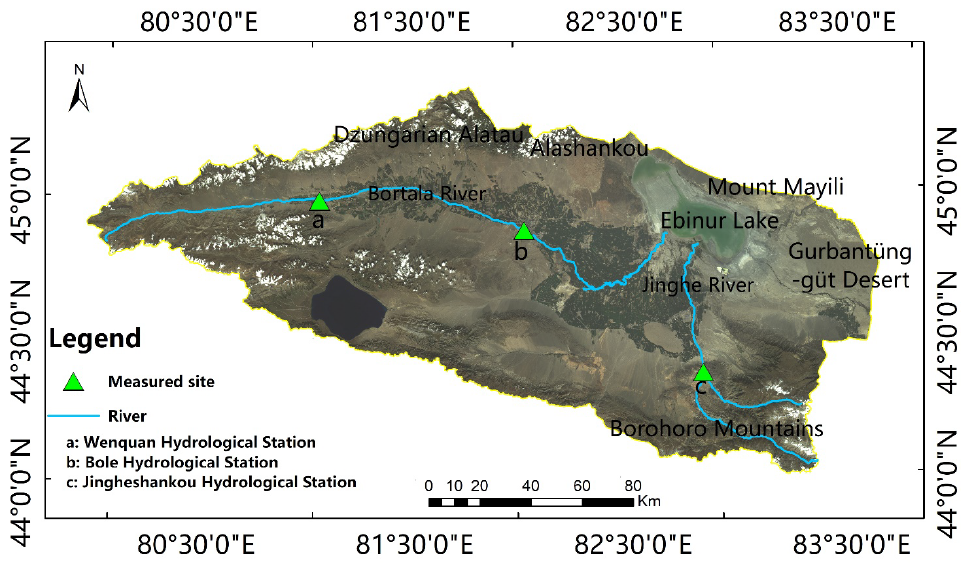
Figure 1. Study area and locations of ground measurement stations.